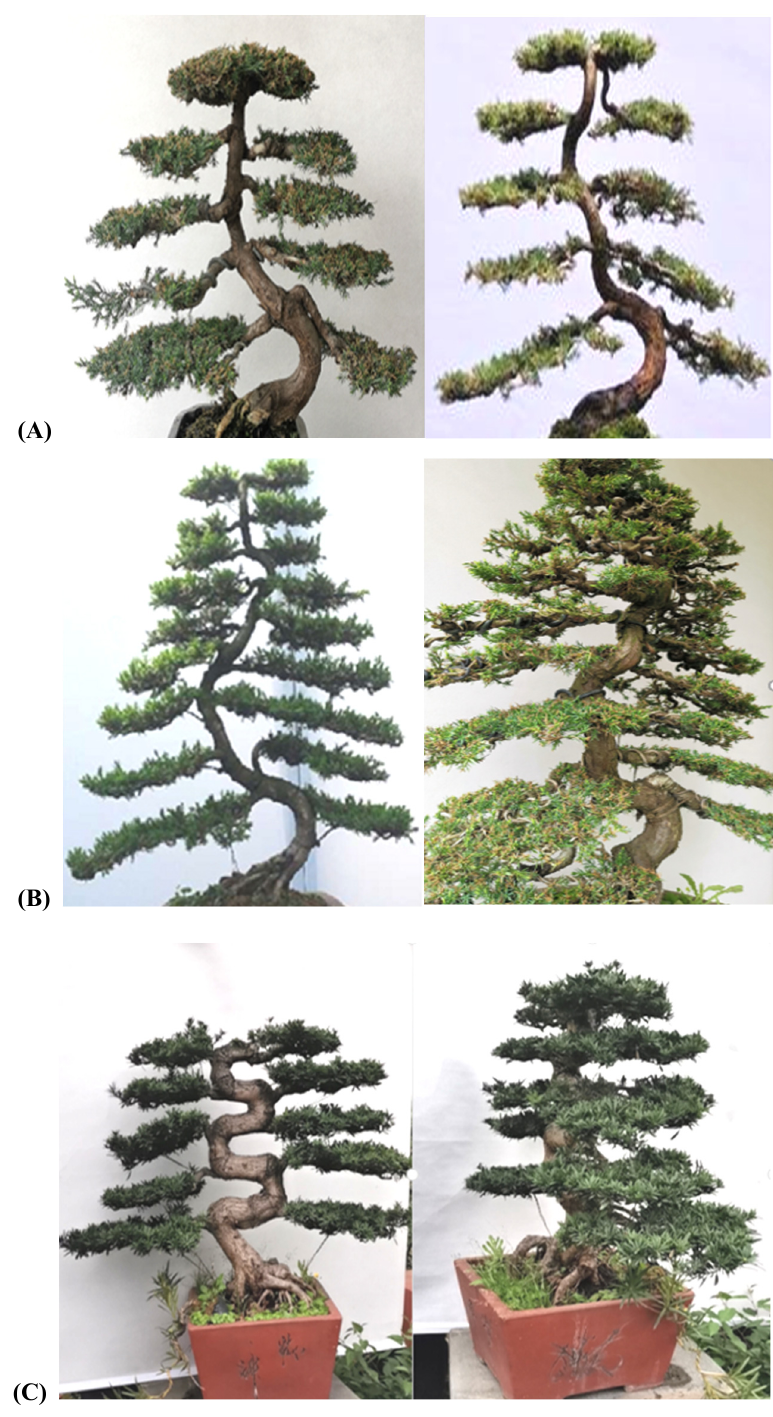
Figure 3. Front/side views of the TBS ( A ), TBNTS ( B ), and SBS ( C ) methods.